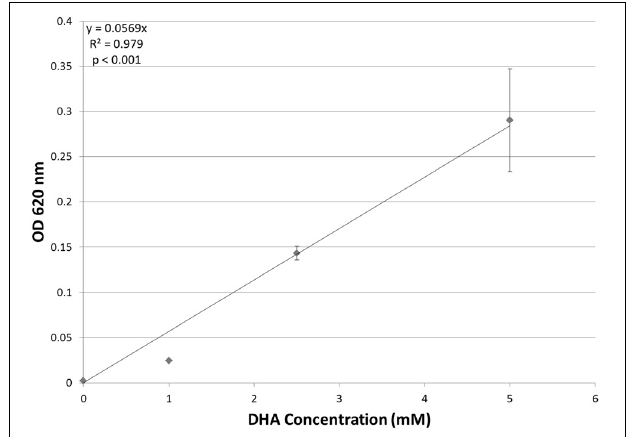
FIGURE 2 | Cell density of H. volcanii H26 at stationary phase vs. concentration of DHA. Cell density is represented by the average optical density (OD 620 ) reading of three cell culture replicates. Error bars depict the standard deviation of the averages. The depicted line represents the line of best fit for the data. ANOVA single factor, p < 0 . 001.